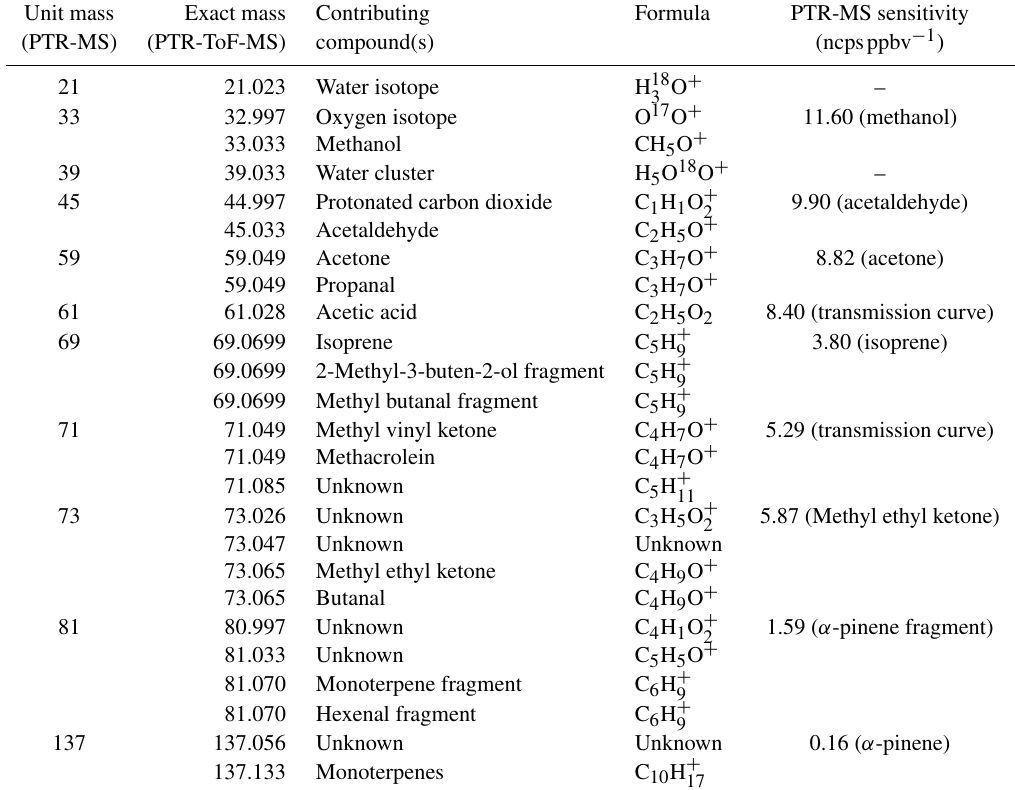
Table 1. Unit masses measured using the PTR-MS during the ÉCLAIRE campaign at Bosco Fontana and the exact masses observed using the PTR-ToF-MS. Where the PTR-MS sensitivity was calculated directly from a compound in the calibration standard, this compound is indicated in brackets. At m/z 61 and 71 the sensitivity was calculated from a transmission